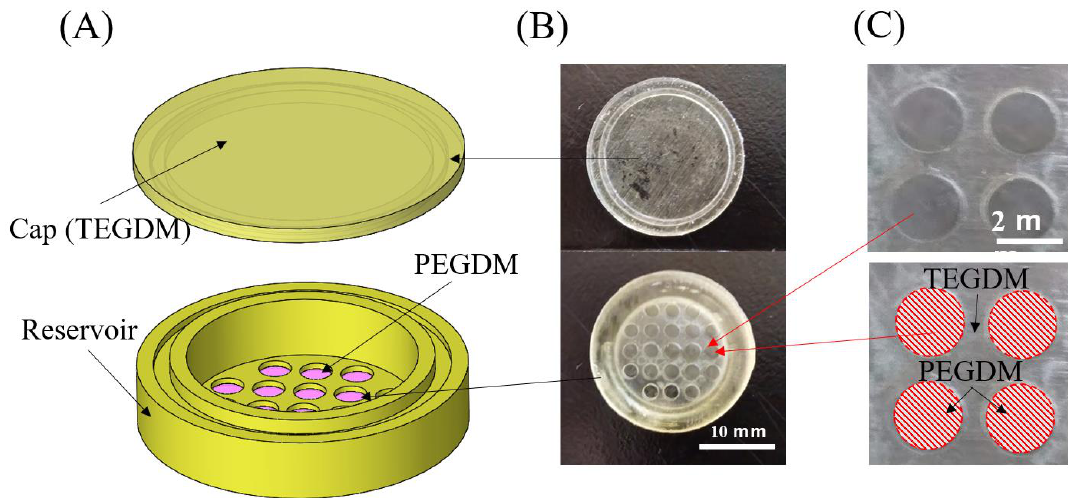
Figure 3. 3D printed cell encapsulation capsule. ( A ) 3D exploded view of the CAD model. ( B ) Top view of the actual fabricated device ( C ) Magnified view of the reservoir showing multi-material printing of a semi-porous PEGDM membrane and non-porous TEGDM outer covering.